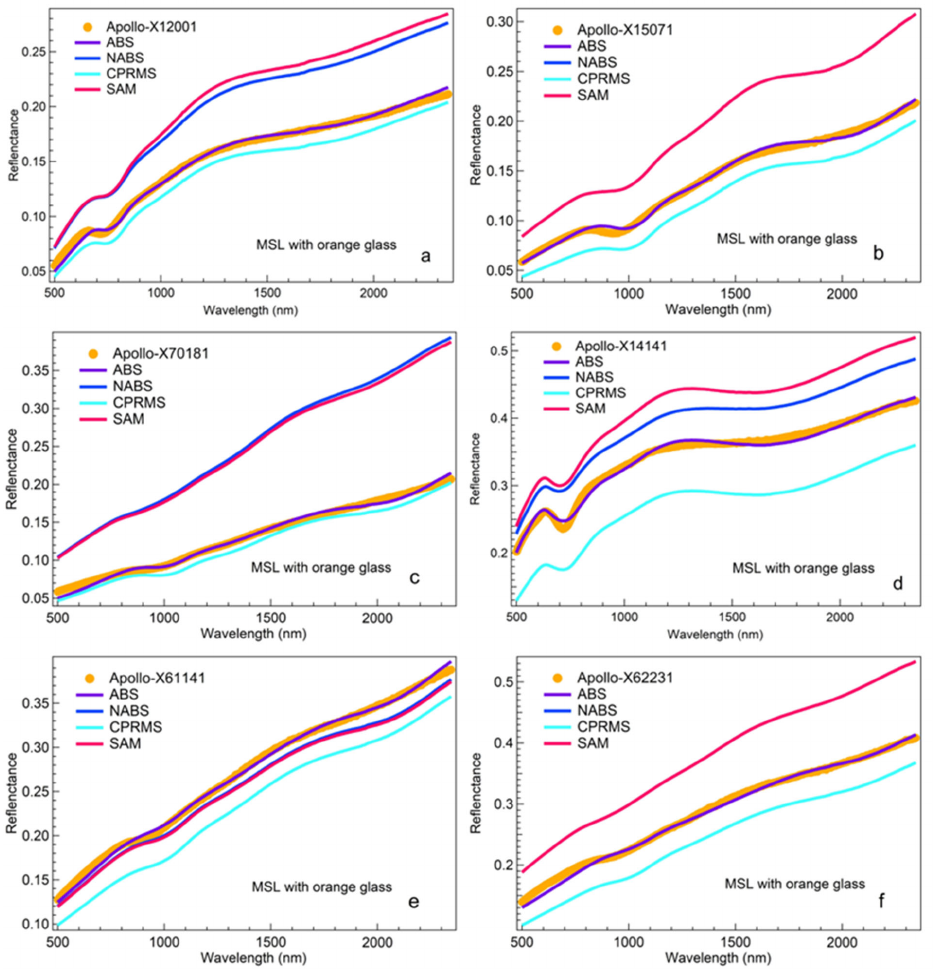
Figure 4. Comparisons of the LSCC measurement spectra with the corresponding best ‐ matched MSL spectra with orange glass were obtained using four different fitting metrics for ( a ) X12001, ( b ) X15071, ( c ) X14141, ( d ) X70181, ( e ) X61141, and ( f ) X62231.